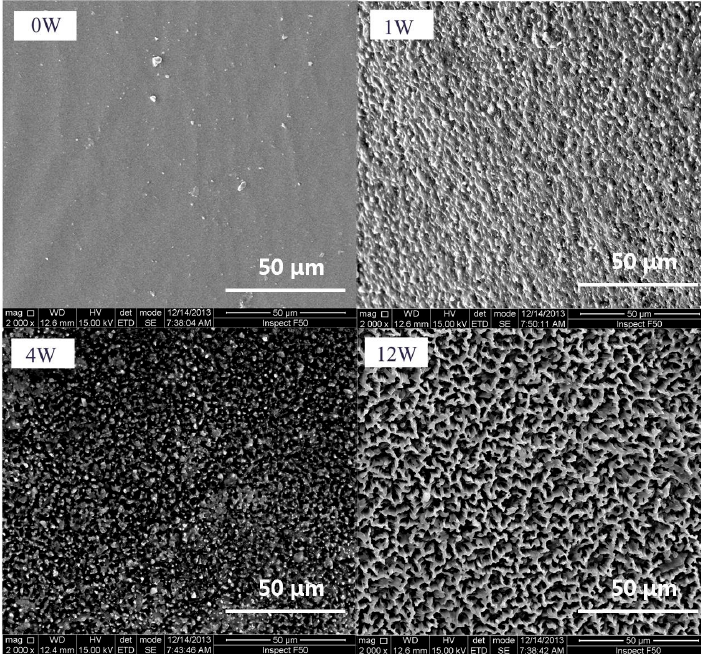
Figure 5. Scanning electron microscope (SEM) micrographs of PTMC 40 -0.1 before and after 1, 4 and 12 weeks’ enzymatic degradation.